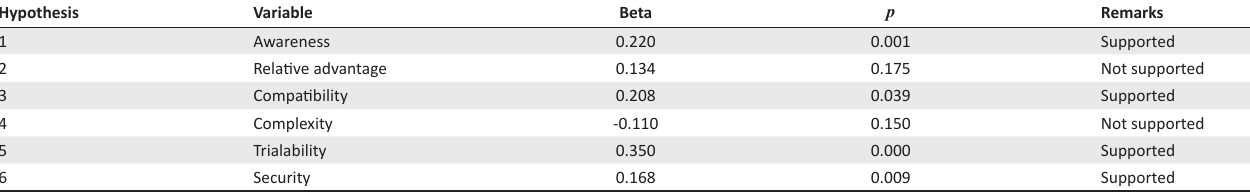
TABLE 4: Hypothesis acceptance and rejection test